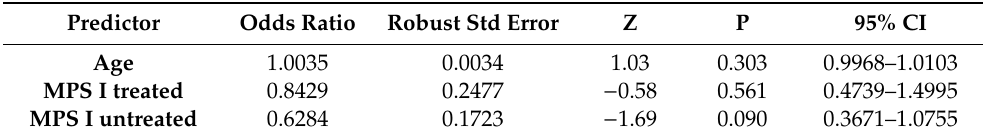
Table 14. Reversal learning mixed e ff ects logistic regression model. Analysis of MPS I a ff ected groups compared to normal group for choice (correct vs. incorrect) at each session x trial and age.